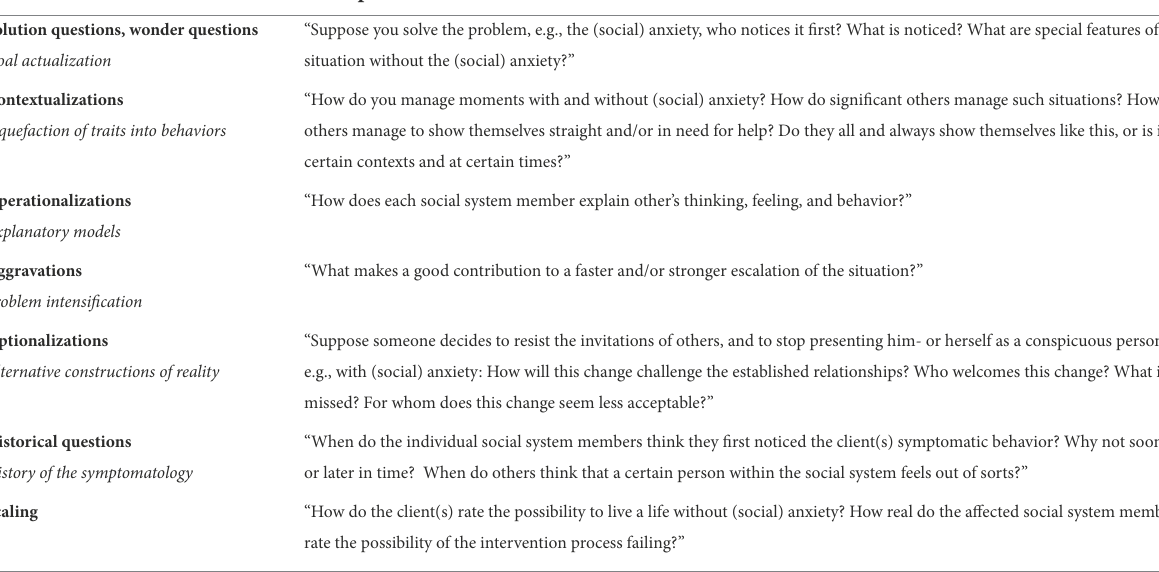
TABLE 7 Modes of systemic questioning (Hunger,